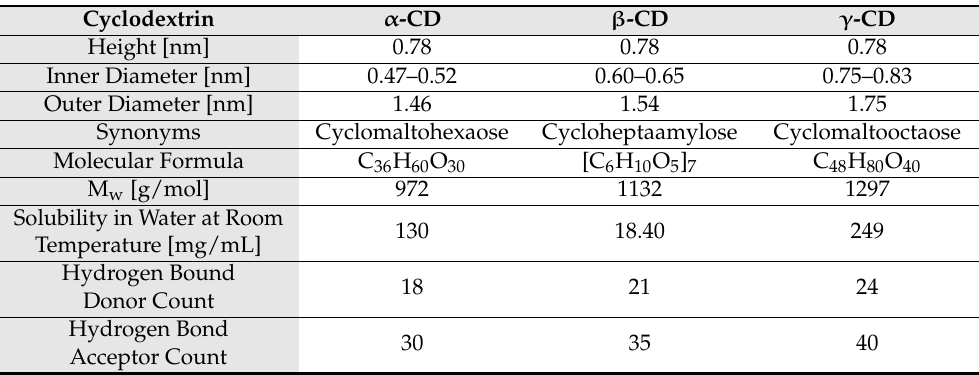
Figure 2. Illustration of cyclodextrins’ structure. Cyclodextrins are monomeric units of sugar molecules (glucopyranosides) arranged in rings. Depending on the number of sugar molecules (6, 7, or 8), they are classified as α -, β -, or γ -cyclodextrins, respectively, showing a general 3D overall shape [37]. Table 2. Characteristics of α -CD, β -CD, and γ -CD